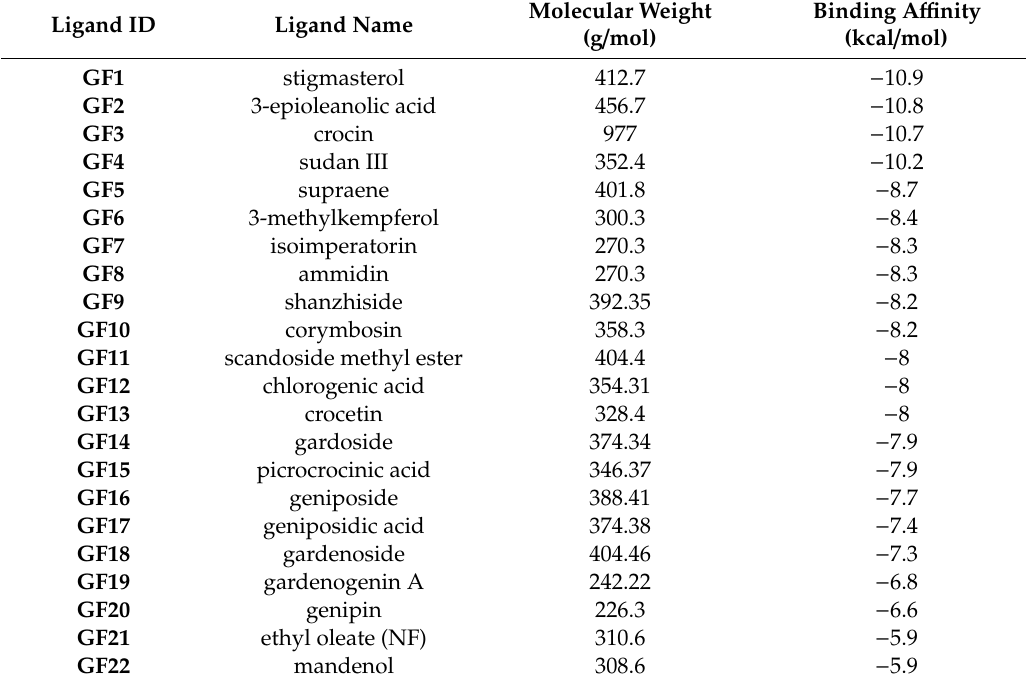
Table 1. Binding a ffi nity of each selected Gardeniae fructus ligand to 5NX2. The binding a ffi nity has been coloured with darker blue, indicating the most negative values. Three ligands highlighted in red have been selected and